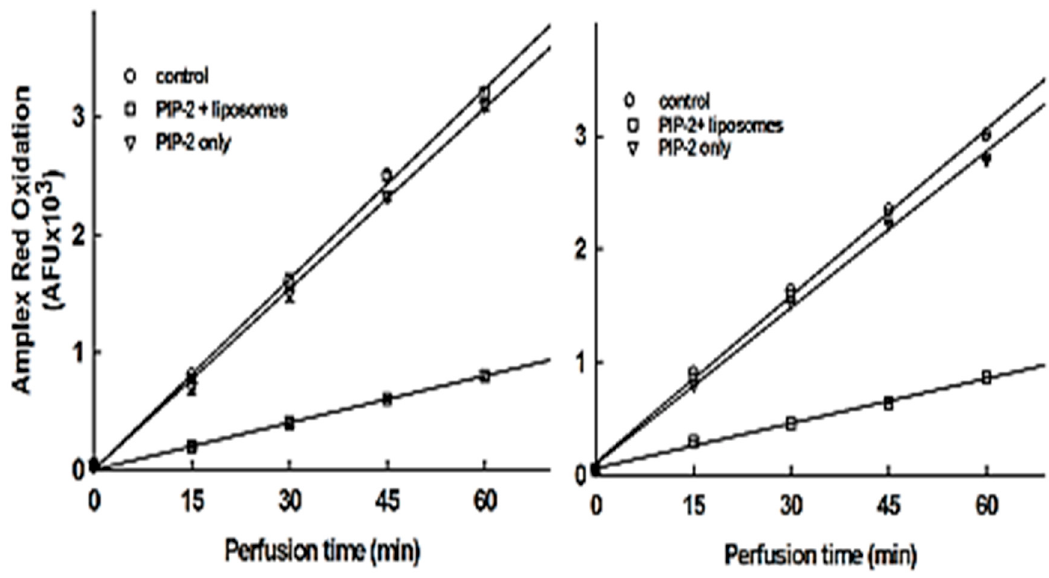
Figure 3. PIP-2 if encapsulated in liposomes inhibits lung ROS production when administered to. mice by either intratracheal (IT) or intravenous (IV) injection. PIP-2, with or without liposomes, and angiotensin II (to stimulate ROS production via NOX2) were administered to intact mice. Lungs were isolated 30 min later and ROS production was measured in the perfused lung by the oxidation of